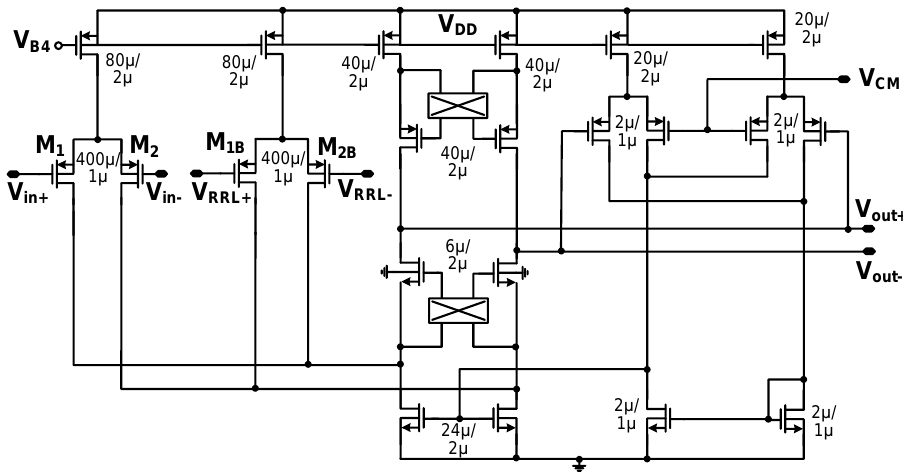
Figure 8. Schematic of the folded-cascode amplifier with common-mode feedback.